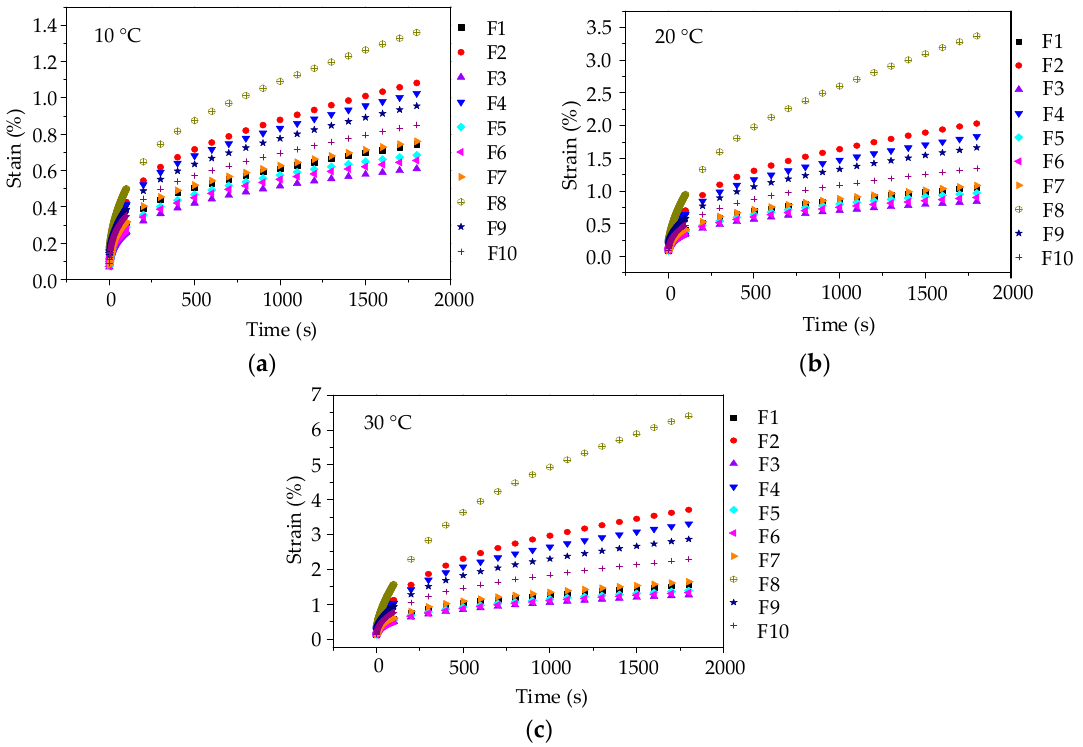
Figure 5. Creep strain ‐ time curves of asphalt mortars: ( a ) 10 °C; ( b ) 20 °C; and, ( c ) 30 °C.